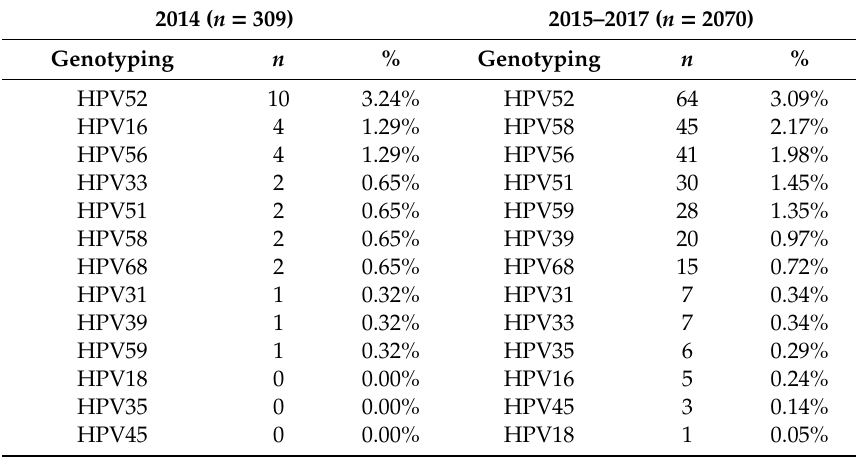
Table 3. Prevalent types of HPV infection.